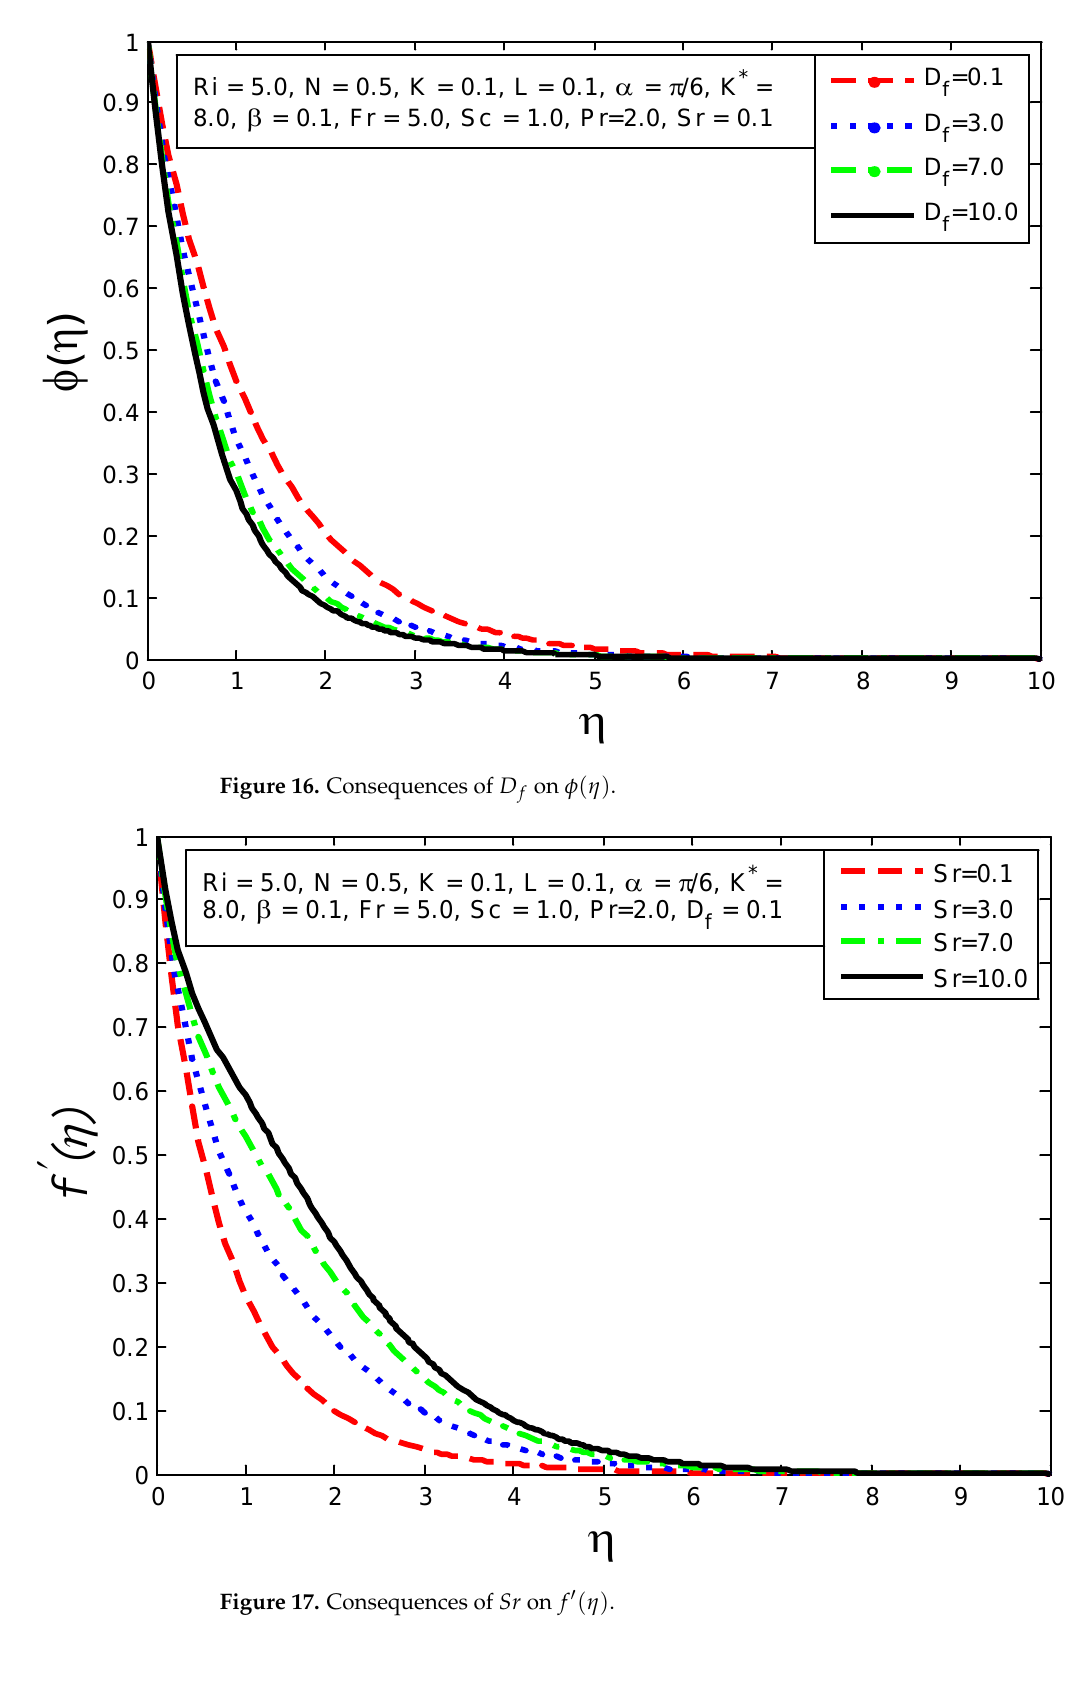
Figure 15. Consequences of